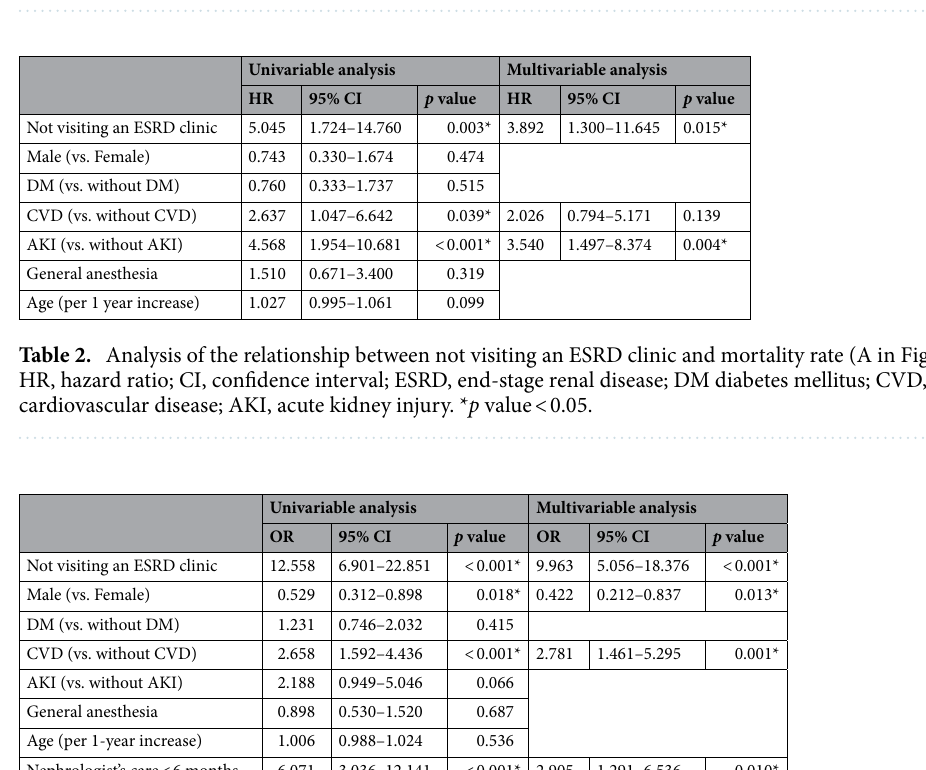
Figure 3. A hypothesis of the relationship between “Not visiting an ESRD clinic,” “Emergent initiation of dialysis,” and “Elevation of mortality rate”.